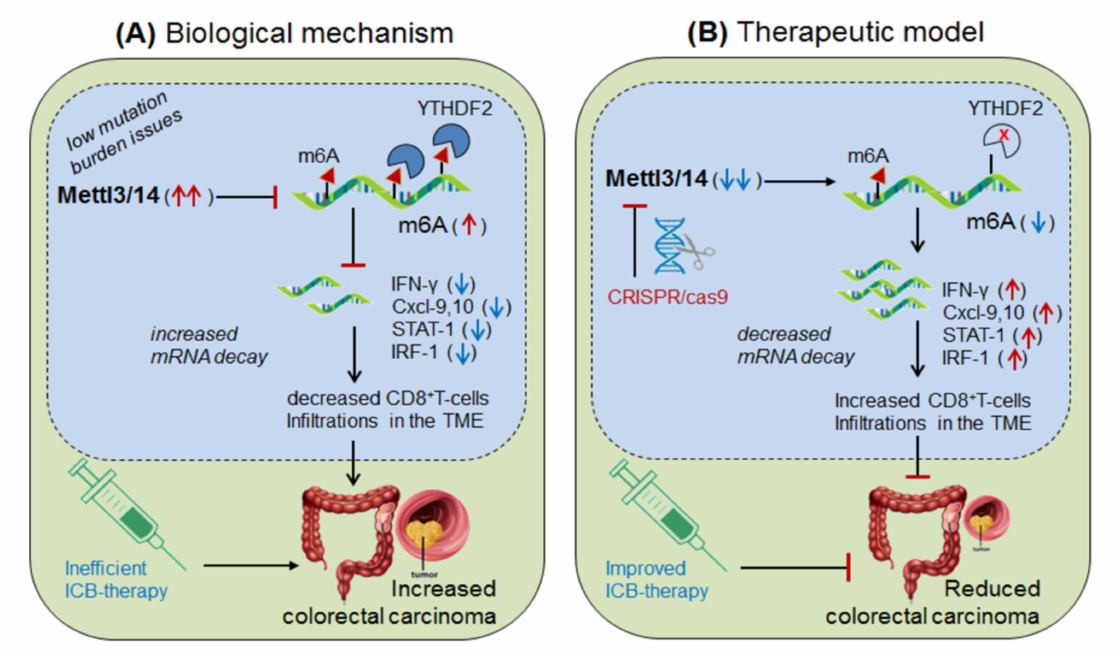
Figure 3. Therapeutic model targeting ‘Mettl-3/14’ in colorectal cancer. ( A ) Biological mechanism: Mettl-3/14 is up- regulated in colorectal cancer and melanoma, and inhibits the expression of IFN γ -STAT1-IRF1 signaling via YTHDF2- mediated (decreased mRNA decay) mechanism and thereby decreases the efficacy of anti-PD-1 effect by lowering CD8 + T- cell infiltrations in the TME, and thus facilitated disease progression. ( B ) Therapeutic model: Anti-Mettl-3/14 therapy: CRISPR/cas9-silencing of Mettl-3/14 increases the expression of its target IFN γ -STAT1-IRF1 genes/signaling by reducing the recruitment of YTHDF2-mediated decay mechanism, and thus enhances the efficacy of anti-PD-1 antibody by increasing infiltrations of CD8 + T-cell in the TME. Moreover, FTO overexpression might decrease Mettl-3/14 level via balancing mecha- nisms, and ‘anti-YTHDF2 therapy’ by directly augmenting target gene expressions, via its mRNA stability mechanisms, might have therapeutic